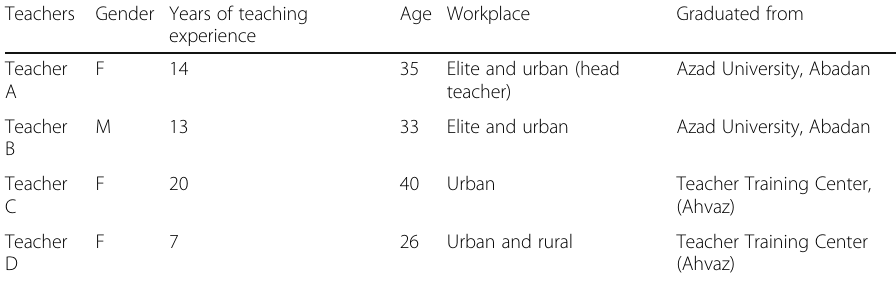
Table 1 Individual teachers ’ characteristics Teachers Gender Years of teaching